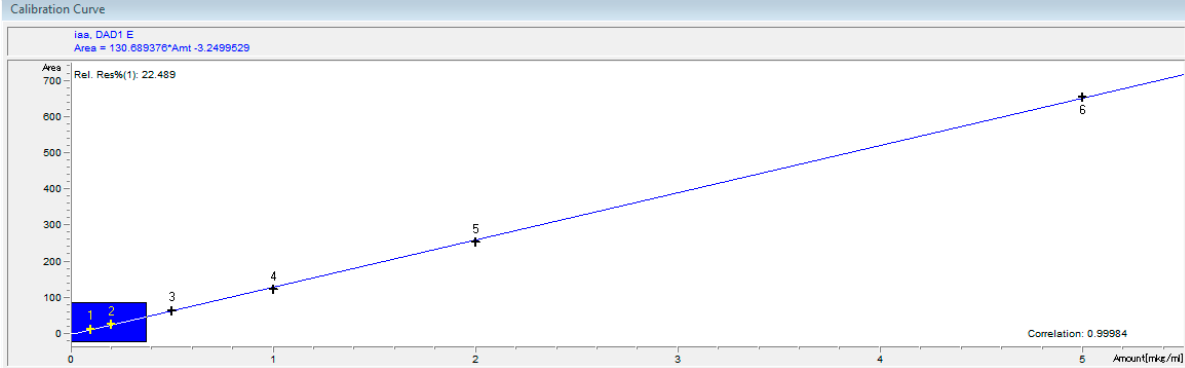
Figure 1. Calibration curve for standard solutions of IAA.